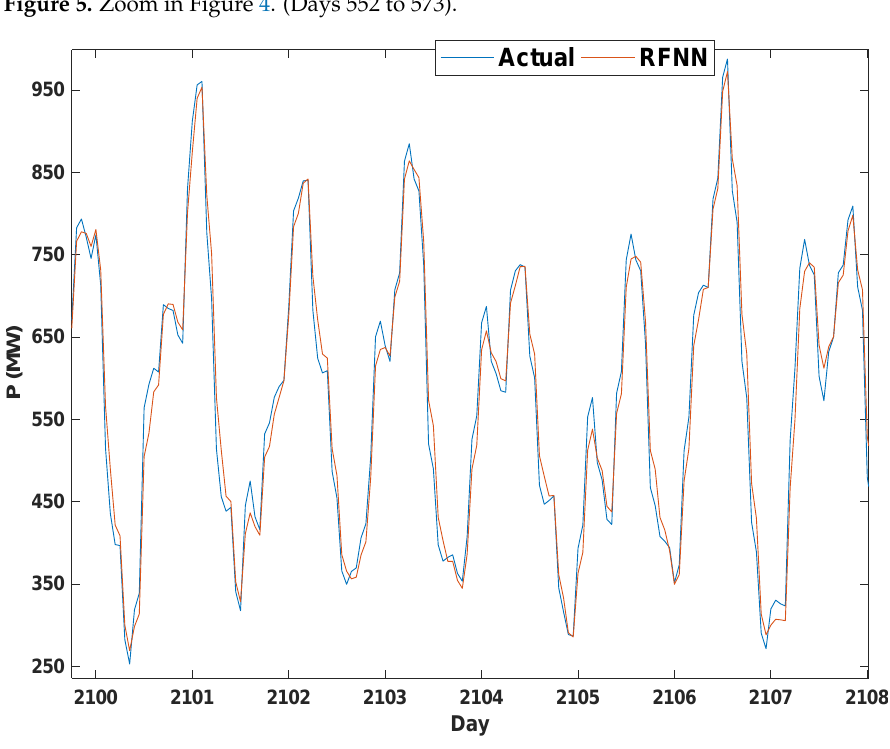
Figure 6. Zoom in Figure 4. (Days 2100 to